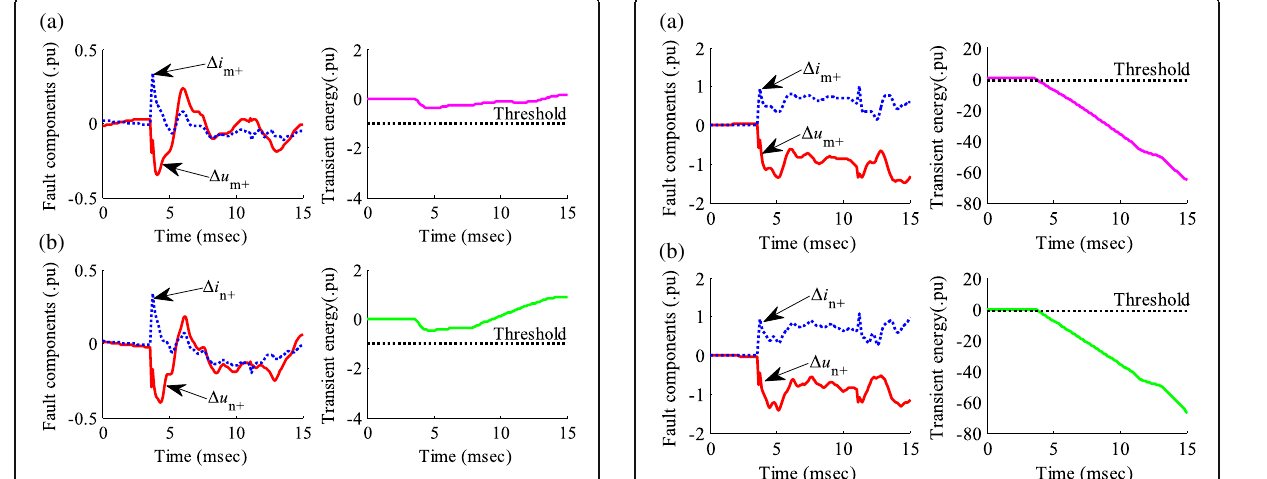
Fig. 9 Waveforms of fault components and transient energies detected on the positive pole line for a fault at F 2. a Rectifier station. b Inverter